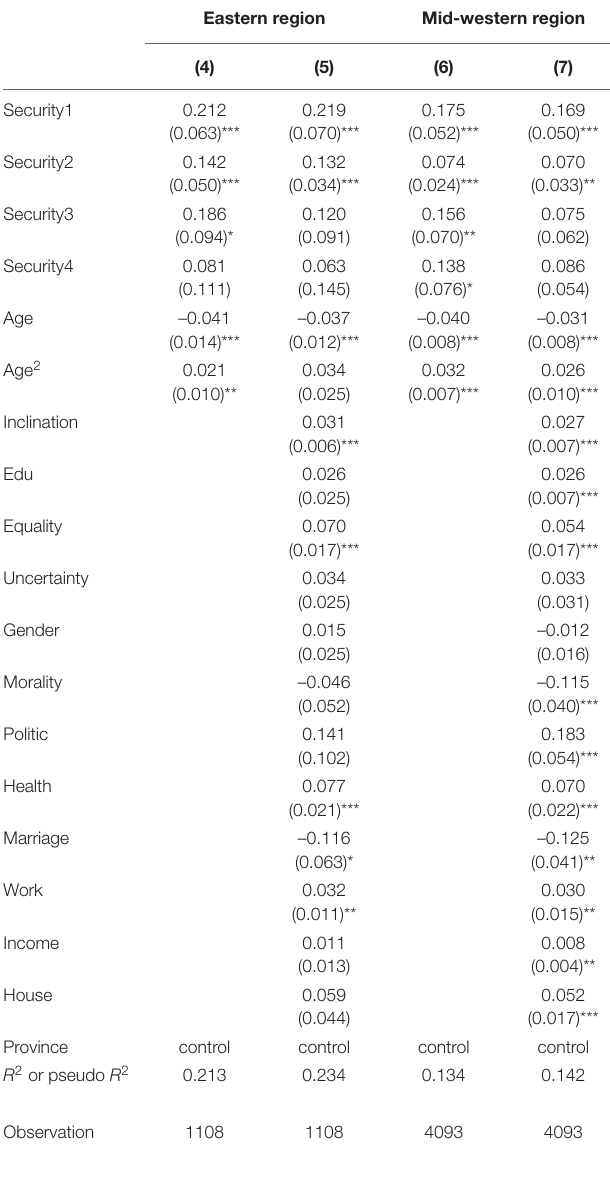
TABLE 5 | Grouping test of Villagers in Eastern and Mid-western